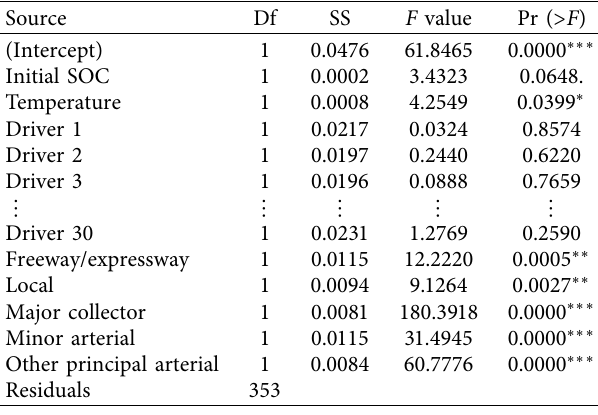
Table 7: Extended ANOVA table of the road type analysis. Source